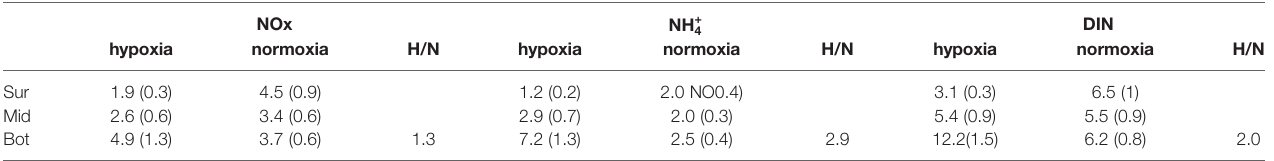
TABLE 4 | The mean of ambient nutrient concentrations (µmol L -1 ) in surface water layer (approximately 0.5 m below the water surface), middle water layer (approximately 6 – 8 m below the water surface), and bottom water layer (approximately 0.5 m above sediment surface) during hypoxia and normoxia periods in Jinhae Bay. NOx NH + 4 DIN hypoxia normoxia H/N hypoxia normoxia H/N hypoxia normoxia